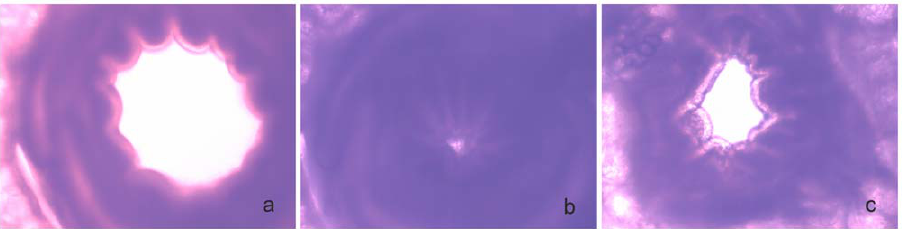
Figure 2. Vitality of PCLS evaluated by bronchoconstriction. To induce bronchoconstriction, the untreated slice (a) was incubated with 10 2 4 M methacholine (b). Removal of the drug resulted in a reverse effect